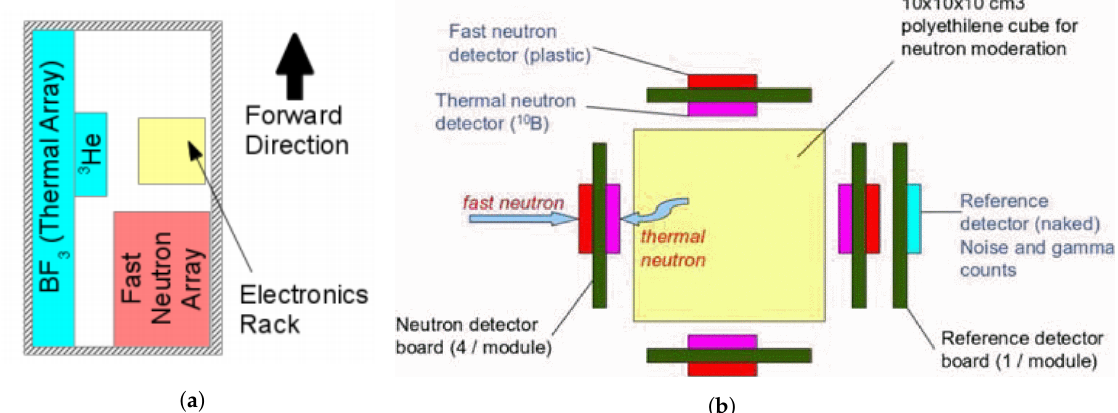
Figure 16. Examples of gamma and neutron detection systems: ( a ) Standoff detection of thermal and fast neutrons carried by a truck (containerized system). ©2021 IEEE. Reprinted, with permission, from Reference [209]. ( b ) Real time wide area radiation surveillance system (REWARD) project: neutron detector unit layout. ©2021 IEEE. Reprinted, with permission, from Reference